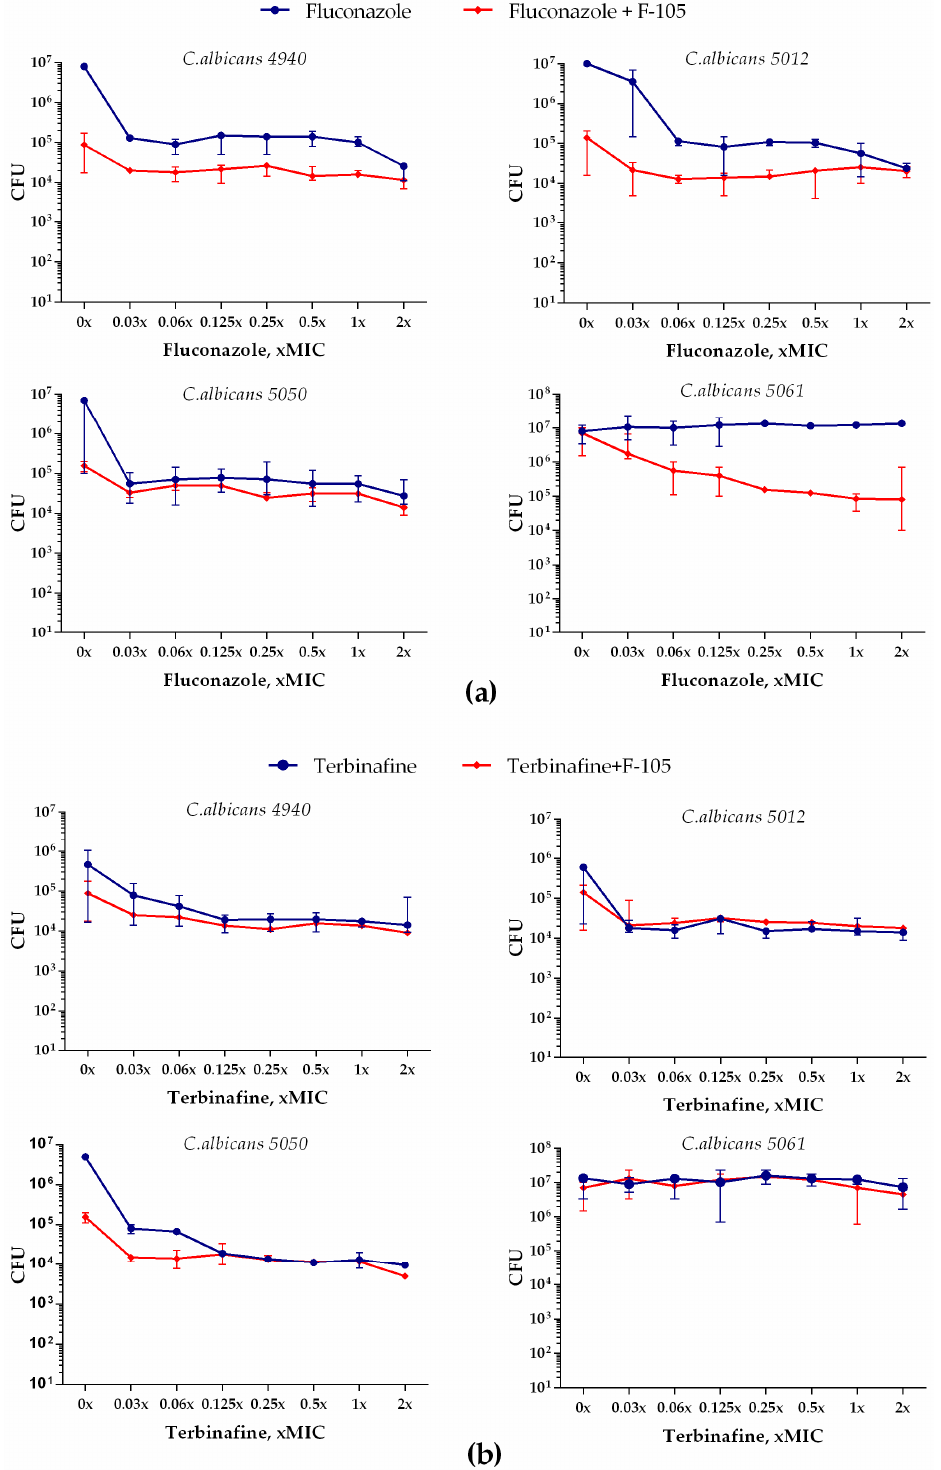
Figure 9. Antifungal effect of fluconazole ( a ) or terbinafine ( b ) alone and in combination with 16 μ g/mL F105 against C. albicans biofilm.